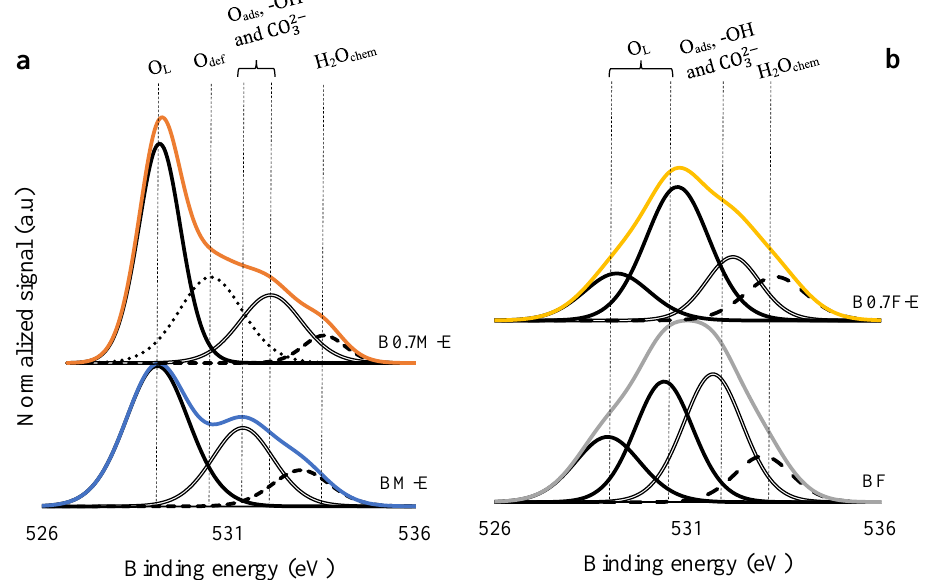
Figure 5. XPS spectra of the O 1 s transition for BM-E and B0.7M-E ( a ) and for BF and B0.7F-E catalysts ( b ).